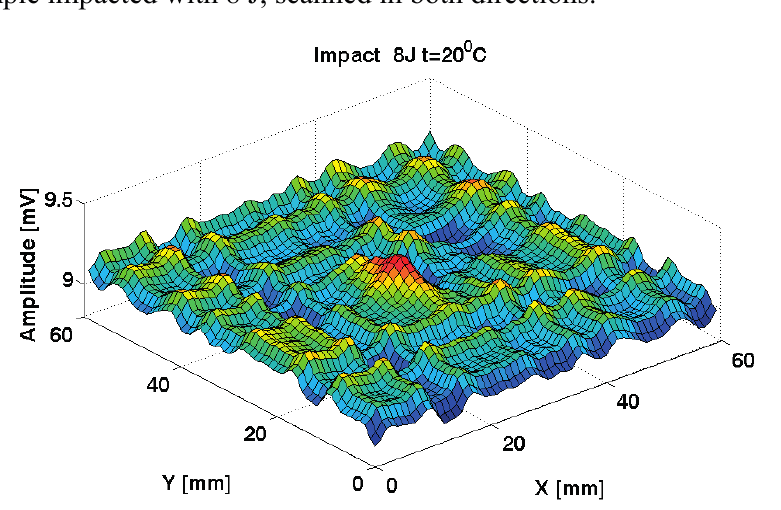
Figure 8. Sensor data with MM lens for 8 J